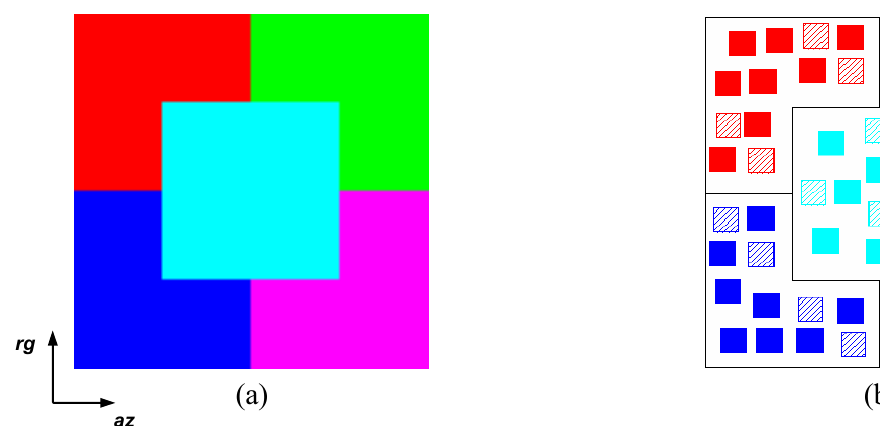
Figure 7. Phantom image and sample locations.